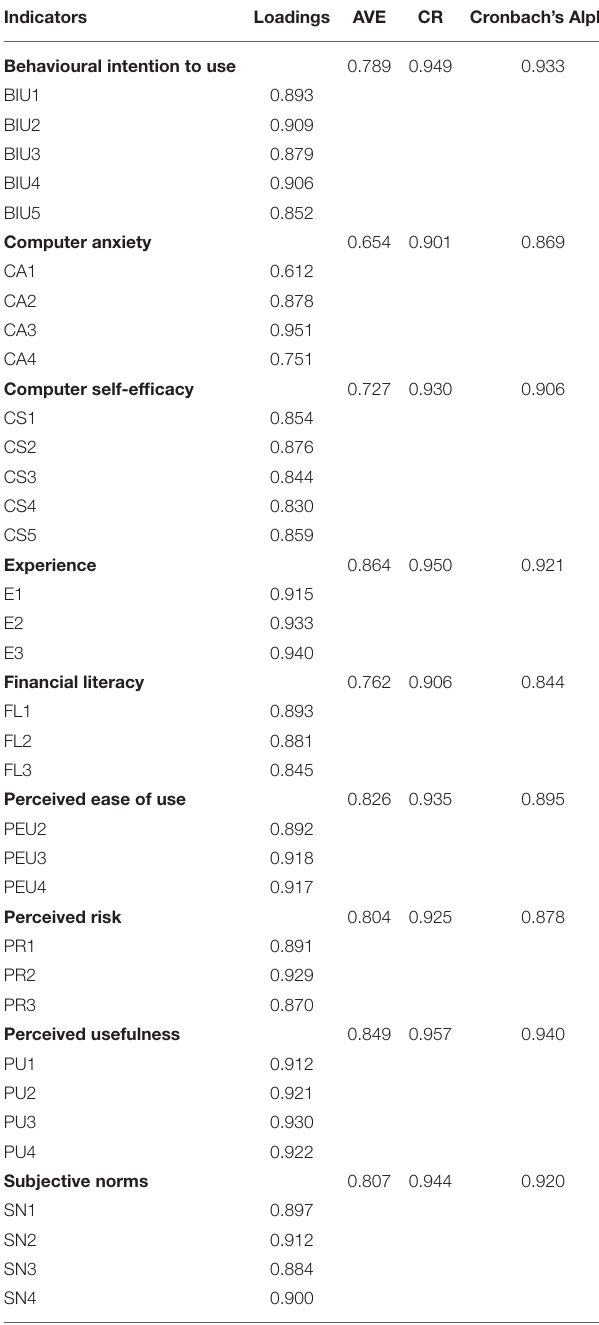
TABLE 3 | Indicators loadings, composite reliability, and average variance extracted of latent